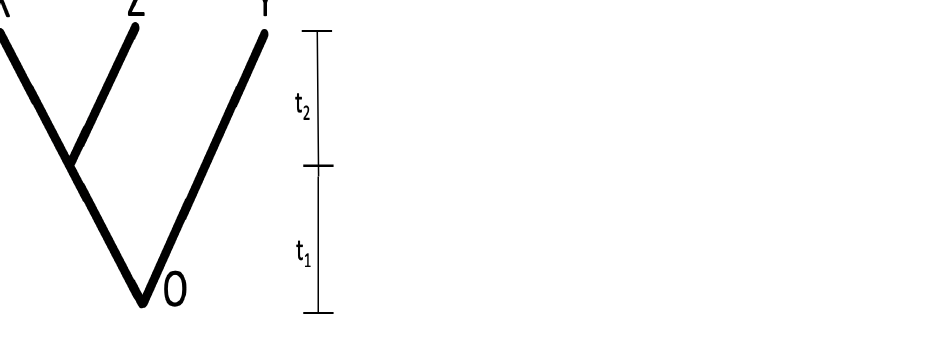
Figure 3. A phylogenetic tree of 3 taxa. X , Z , Y are taxa; O is the root. X and Z share the same branch length on t 1 . Y is independent with both X and Z